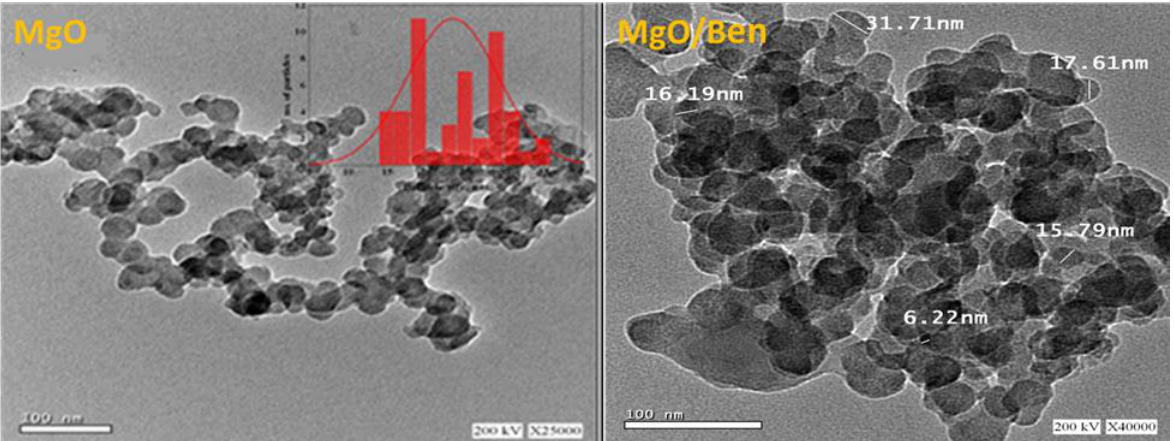
Figure 2. TEM images of MgO NPs and MgO/Ben nanocomposite.